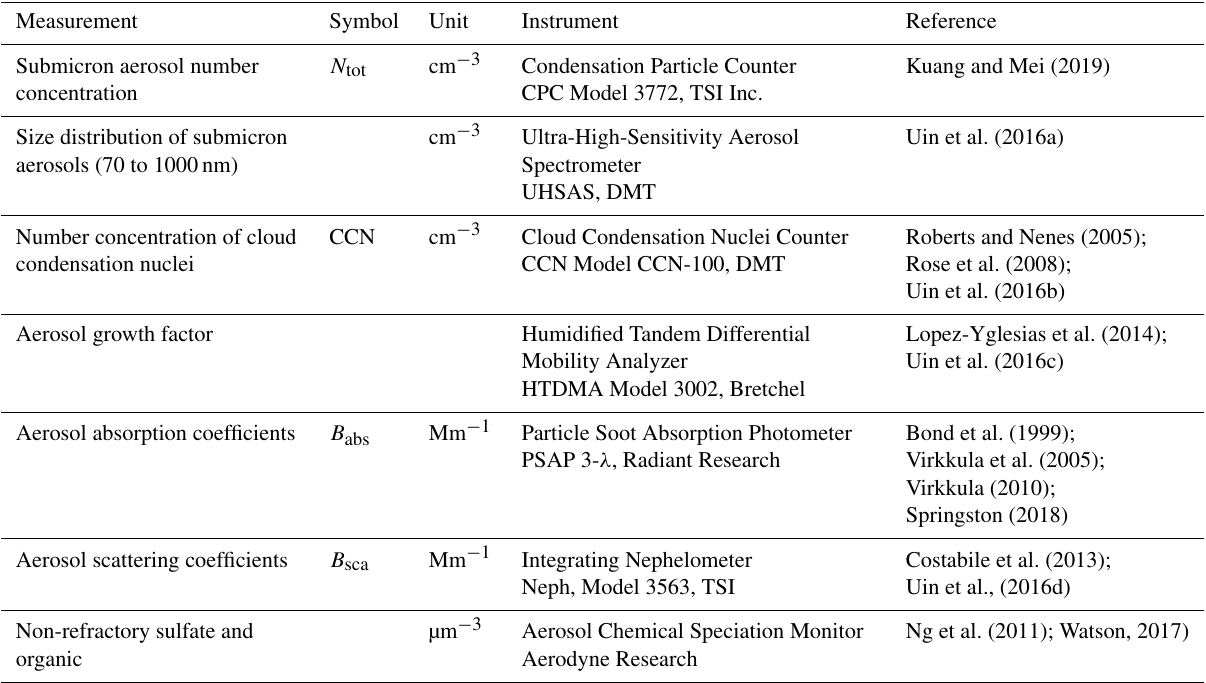
Table 1. Aerosol observing system measurements at the ENA ARM site analyzed in this study.